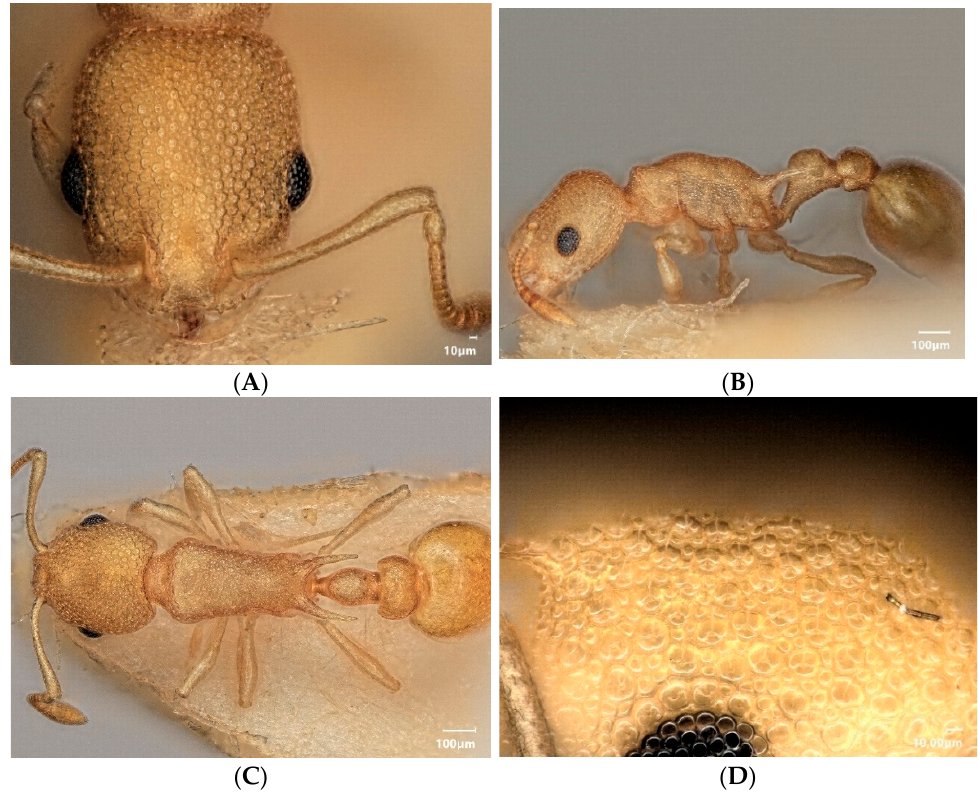
Figure 14. Cardiocondyla micropila n.sp., holotype: head in dorsal view ( A ), lateral view ( B ), dorsal view ( C ), vertex median of the eye ( D ).